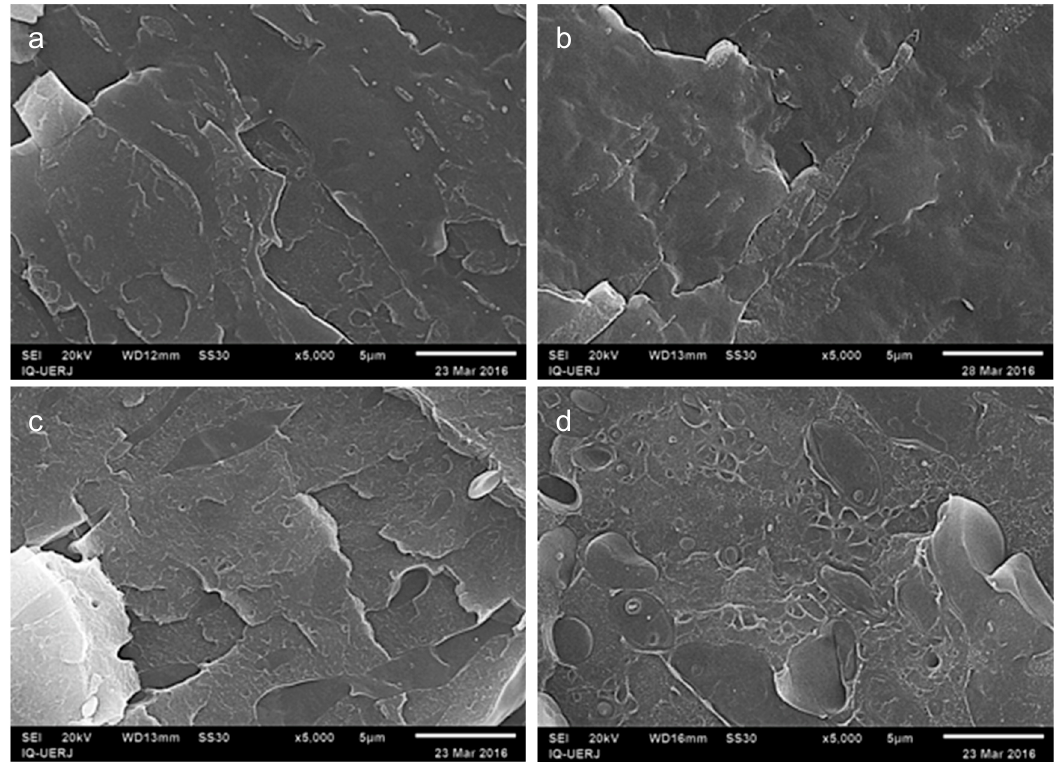
Figure 3. SEM micrographs for the blends PP/ HIPS: ( a ) 4:1 without CNSL; ( b ) 4:1 with 5 phr of CNSL; ( c ) 1:4 without CNSL; ( d ) 1:4 with 5 phr of CNSL. Magnification 5000×.